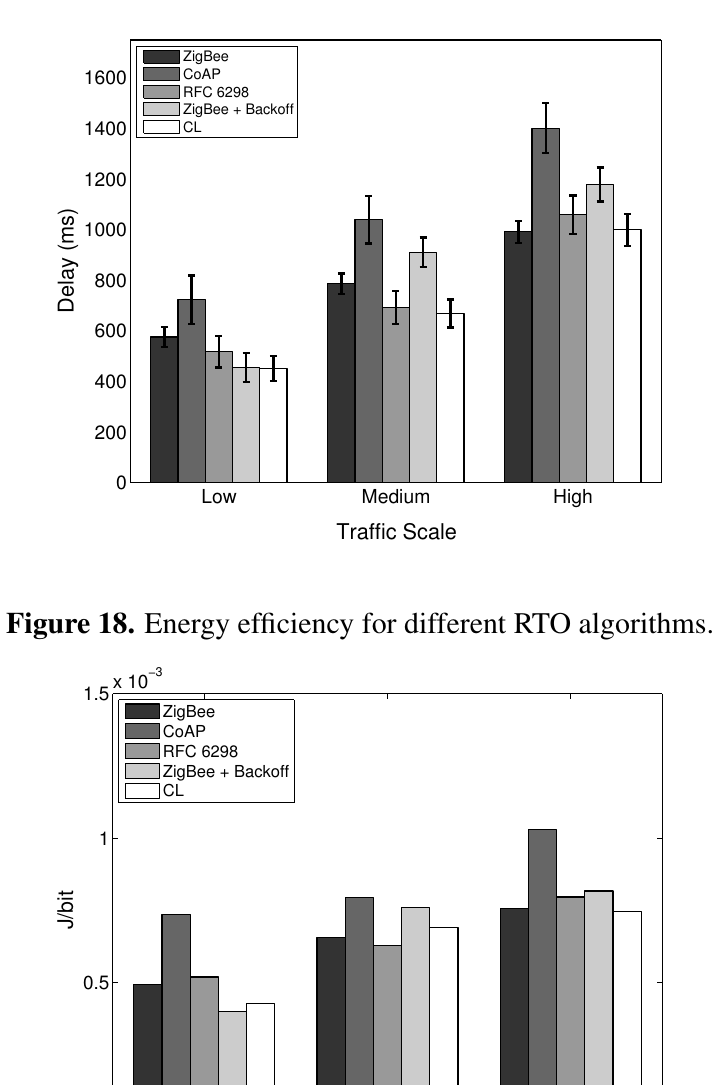
Figure 17. Average end-to-end delays with 95% confidence intervals for different RTO algorithms.